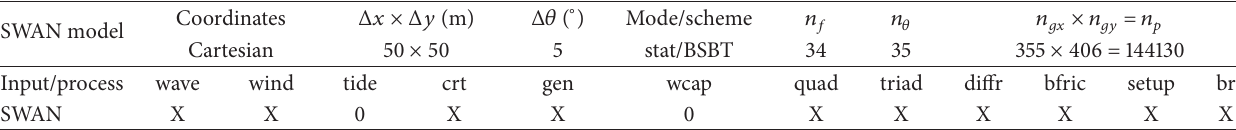
Table 1: Characteristics of the computational domain defined for the SWAN simulations and the physical parameterizations activated. SWAN model